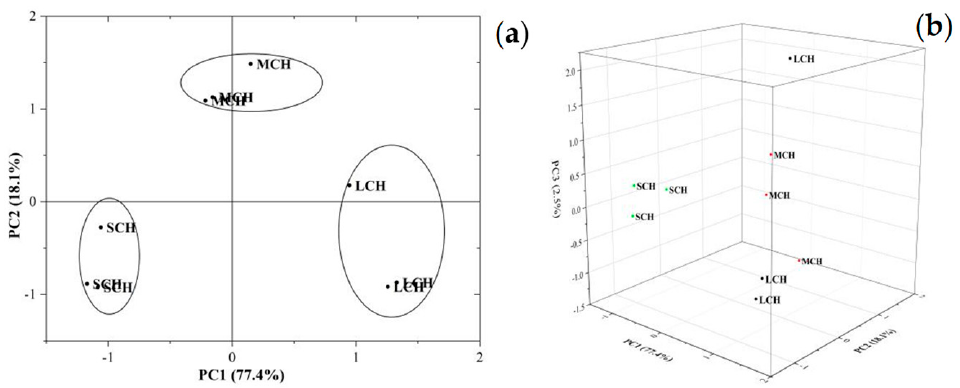
Figure 3. Two dimensional-PCA ( a ) and 3D-PCA ( b ) of volatile profiles in coconut